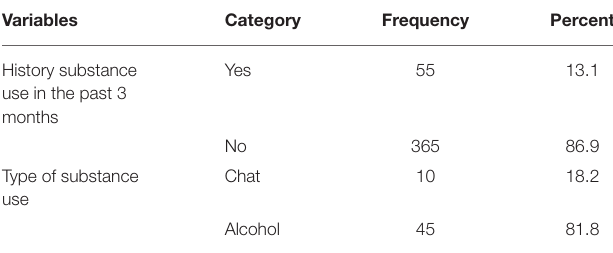
TABLE 3 | History of substance use in the past 3 months among postpartum mothers in Debre Tabor Town North West Ethiopia 2021. Variables